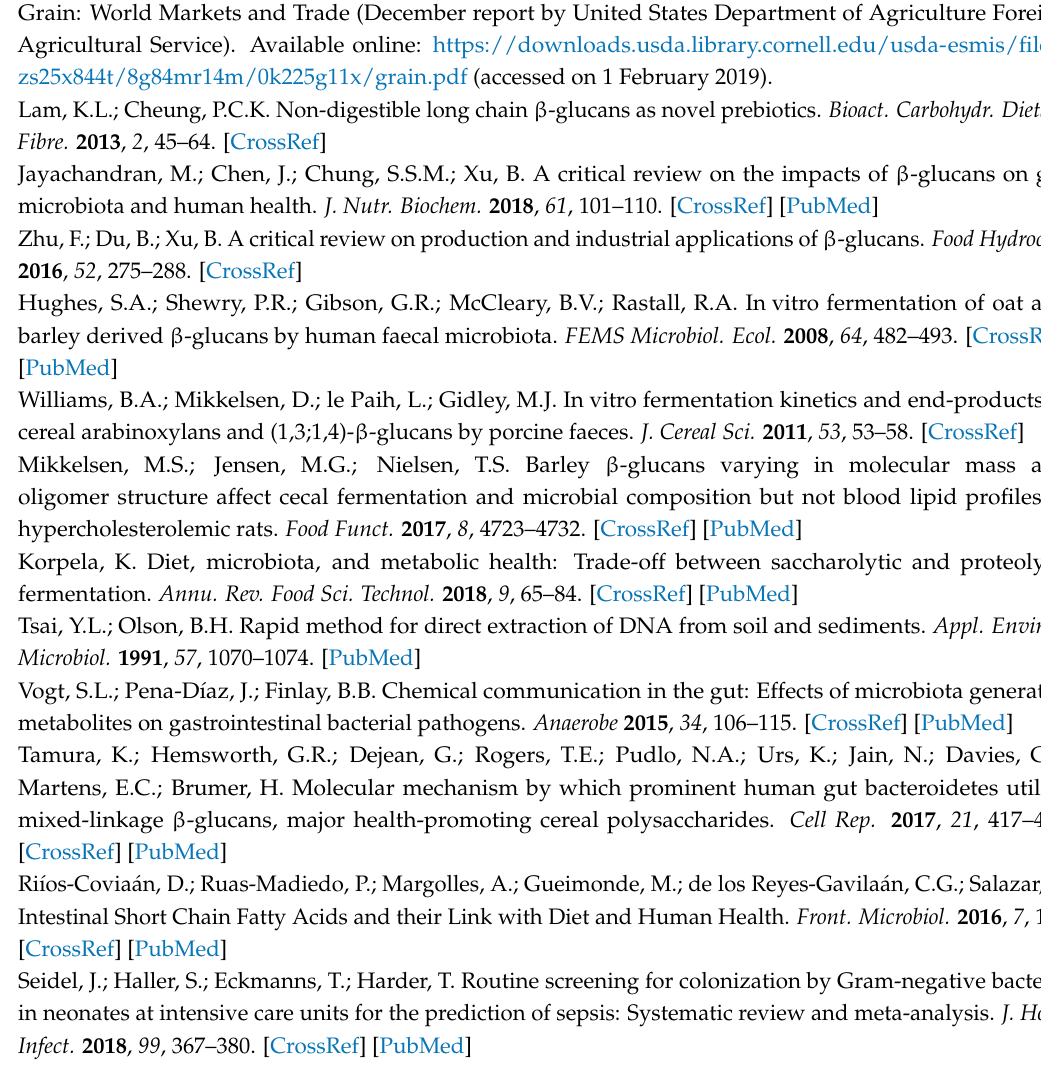
Figure S5, Selected metagenome KEGG prediction output of the infant faecal fermentation of 5 BBG samples and glucose monomer using PICRUSt and statistically analysis using STAMP. ( A ) Carbohydrate metabolism; ( B ) ABC transporters; ( C ) Bacterial secretion system; and ( D ) Glycan biosynthesis and metabolism. Figure S6, Selected metagenome KEGG prediction output of the infant faecal fermentation of 5 BBG samples and glucose monomer using PICRUSt and statistically analysis using STAMP. ( A ) Lipid metabolism; ( B ) Protein digestion and absorption; ( C ) Amino acid metabolism; and ( D ) Nitrogen metabolism. Table S1, All the identified microbial taxa of the 5 BBGs (XLSX format). Table S2, The output of PICRUSt metagenome prediction of infant faecal fermentation of 5 BBG samples and glucose (XLSX format). Table S3, The output of LEfSe of infant faecal fermentation of 5 BBGs and glucose (XLSX